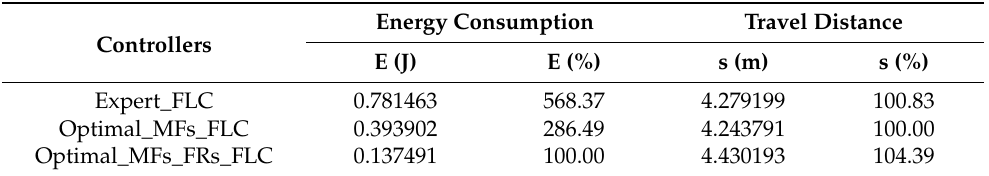
Figure 17. The simulation results in the case of using the sharp turn path. ( a ) The trajectory of the robot; ( b ) The robot’s travel distance over time; ( c ) The robot’s linear velocity over time; ( d ) The robot’s angular velocity over time; ( e ) The robot’s kinetic energy loss over time; and ( f ) The zoom of the robot’s kinetic energy loss over time. Table 17. The kinetic energy loss and the travel distance of the robot when the robot tracks the sharp turn path by the different